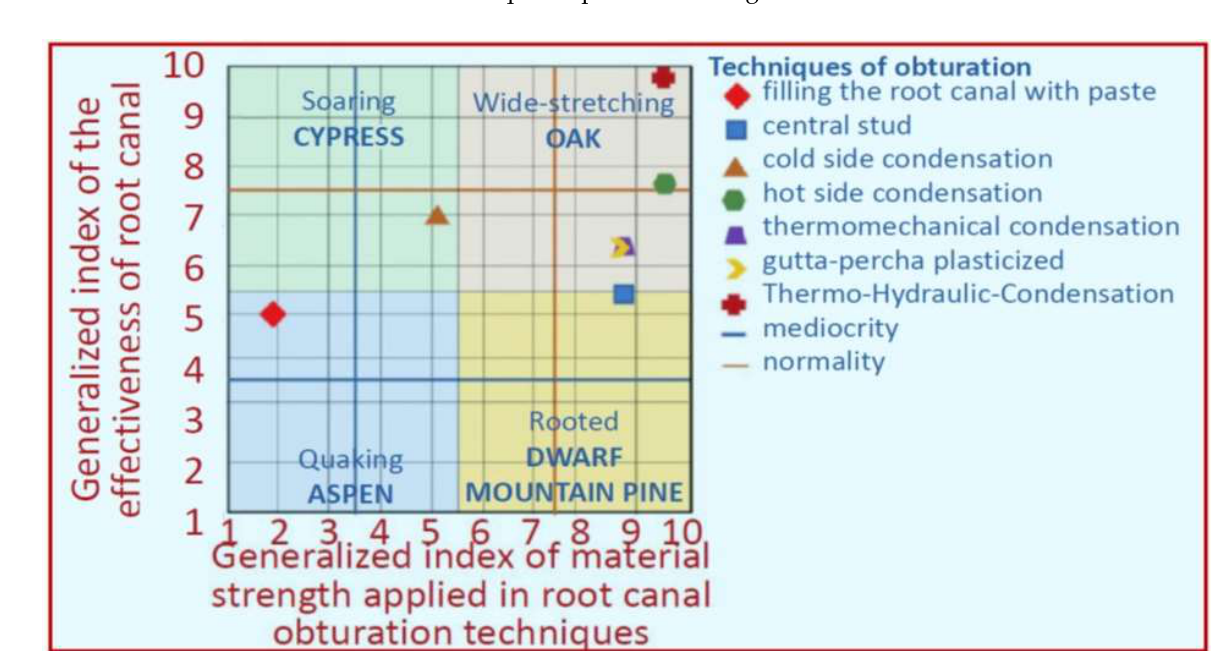
Figure 11. Contextual matrix of the attractiveness of root canal obturation techniques during endodontic treatment.